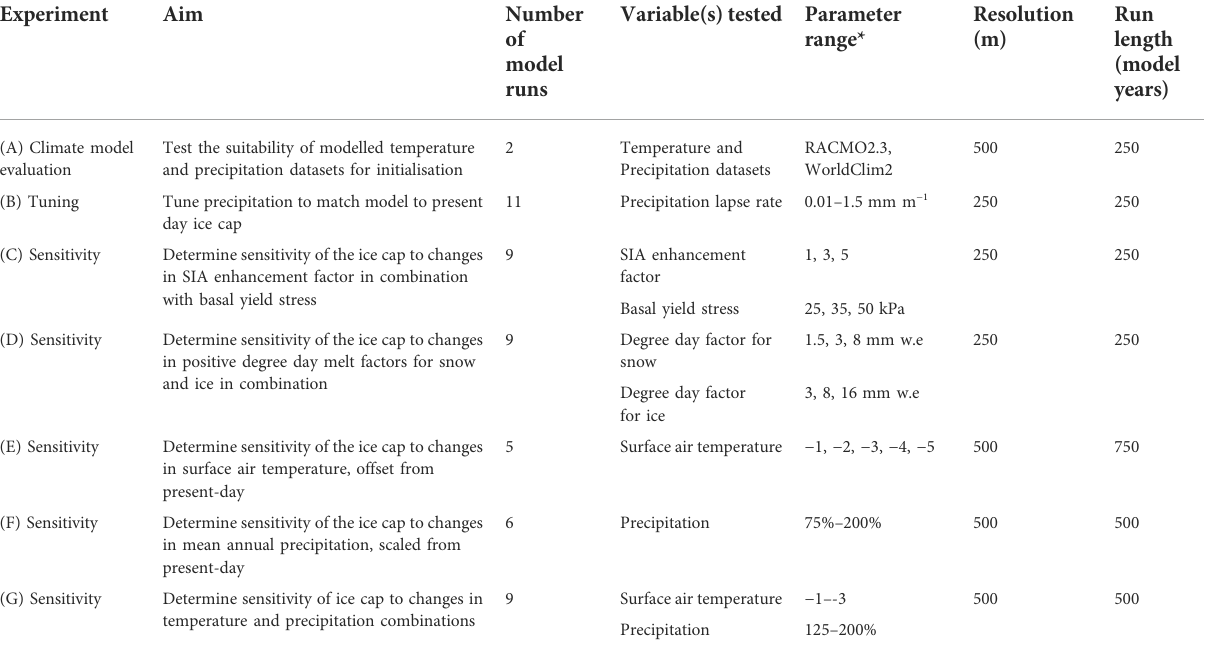
TABLE 4 Model tuning and sensitivity experiments performed in this study, documenting the number of model runs, variable(s) tested, range of parameters explored, the model resolution and model run lengths for each experiment. *references for selected parameters ranges are given under the respective variable in Table